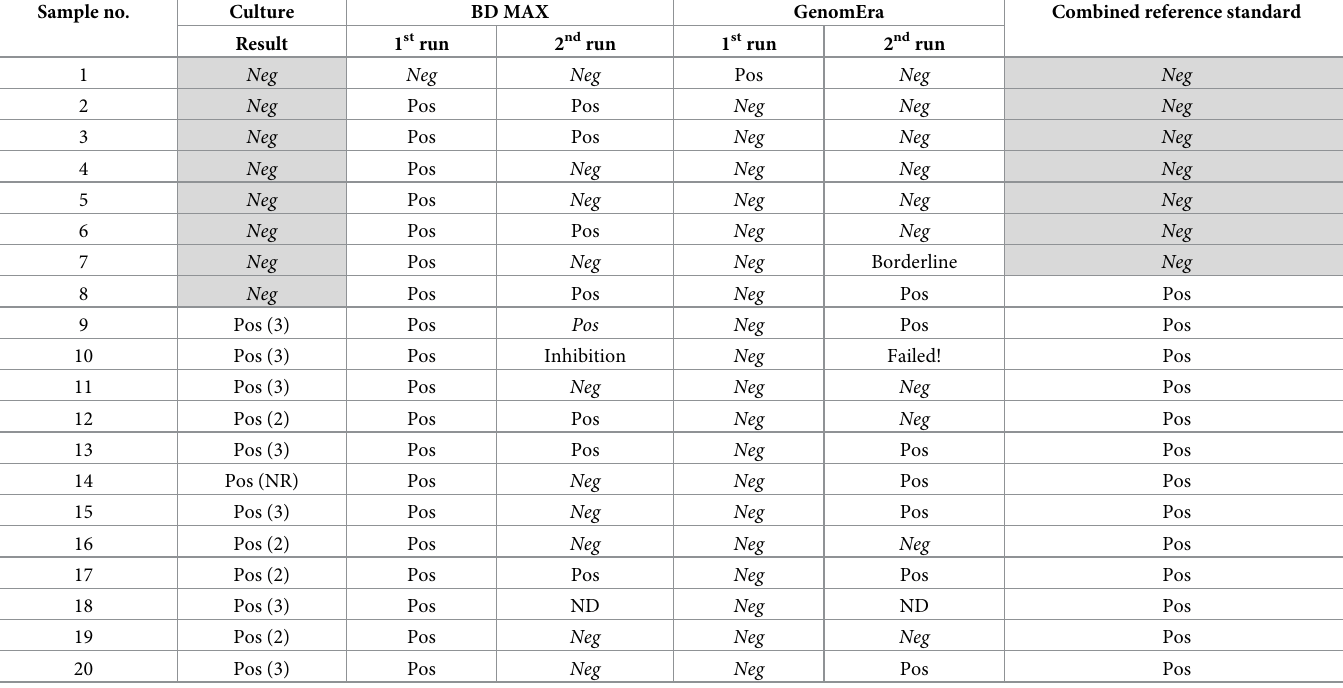
Table 3. Divergent results between BD MAX and GenomEra. Sample no.